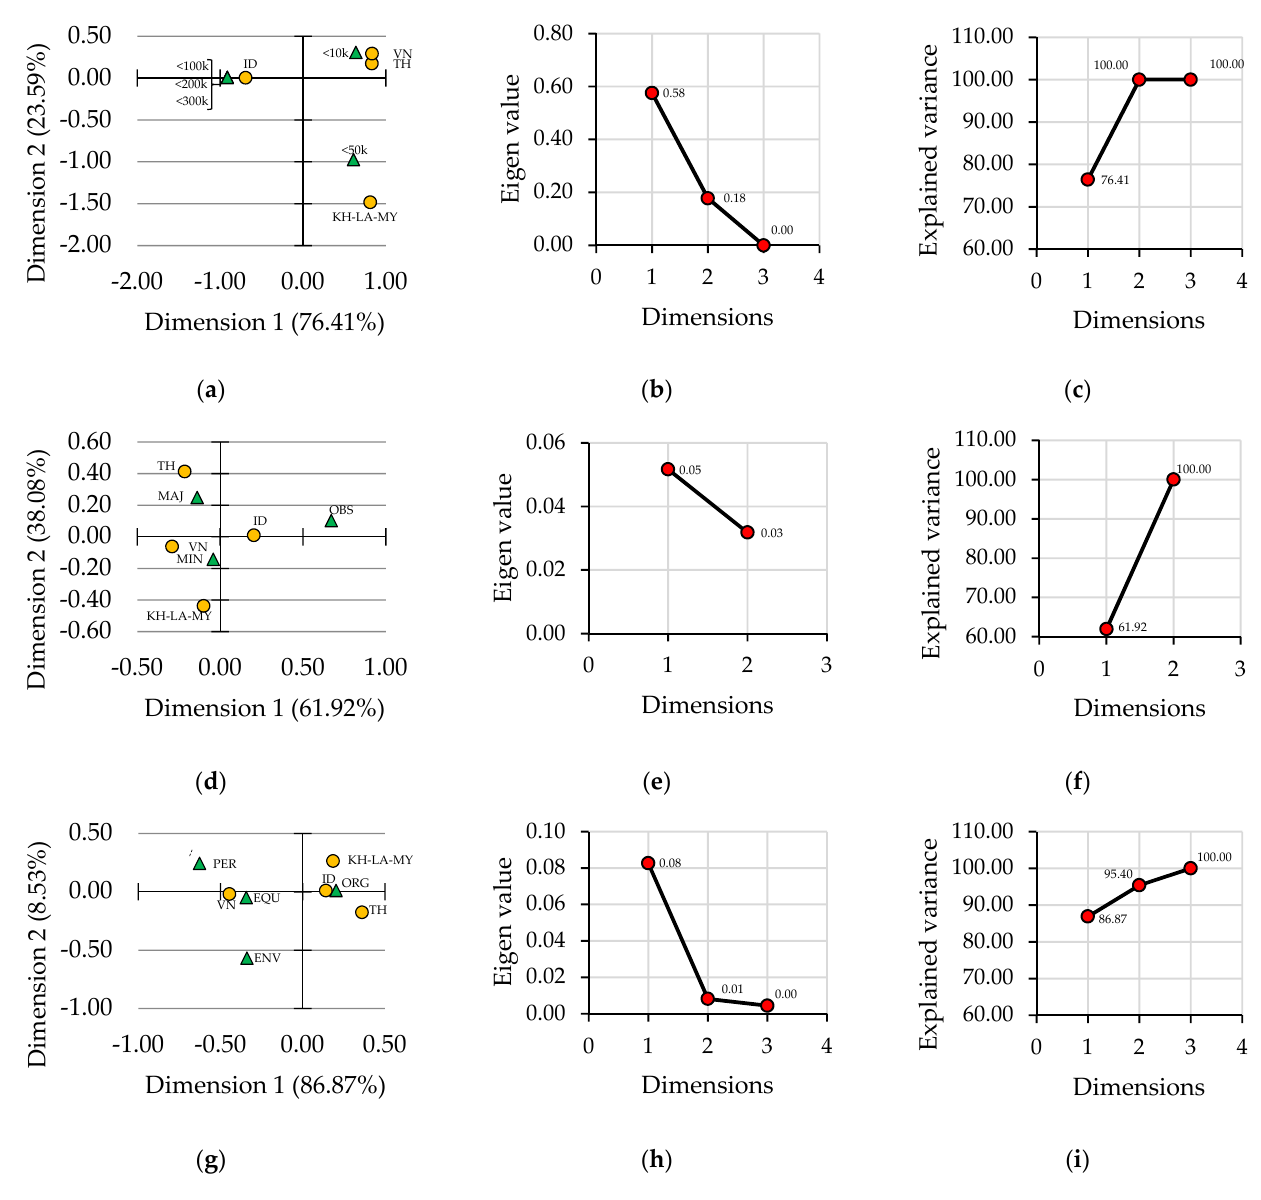
Figure 4. Results of correspondence analysis: ( a – c ) from left to right-combined plot of countries versus certified forest areas, eigen values versus dimensions and explained variance; ( d – f ) from left to right-combined plot of countries versus level of nonconformities, eigen values versus dimensions and explained variance; ( g – i ) from left to right-combined plot of countries versus types of nonconformities, eigen values versus dimensions and explained variance.